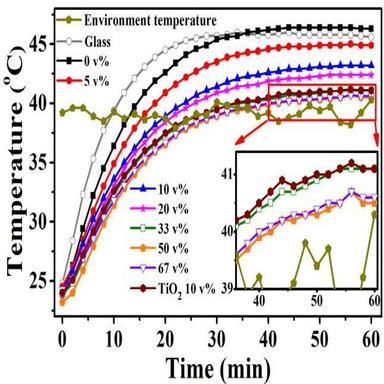
Actual heating curve of PVC films, PVC porous films and PVC/TiO2 composite films tested outdoors.